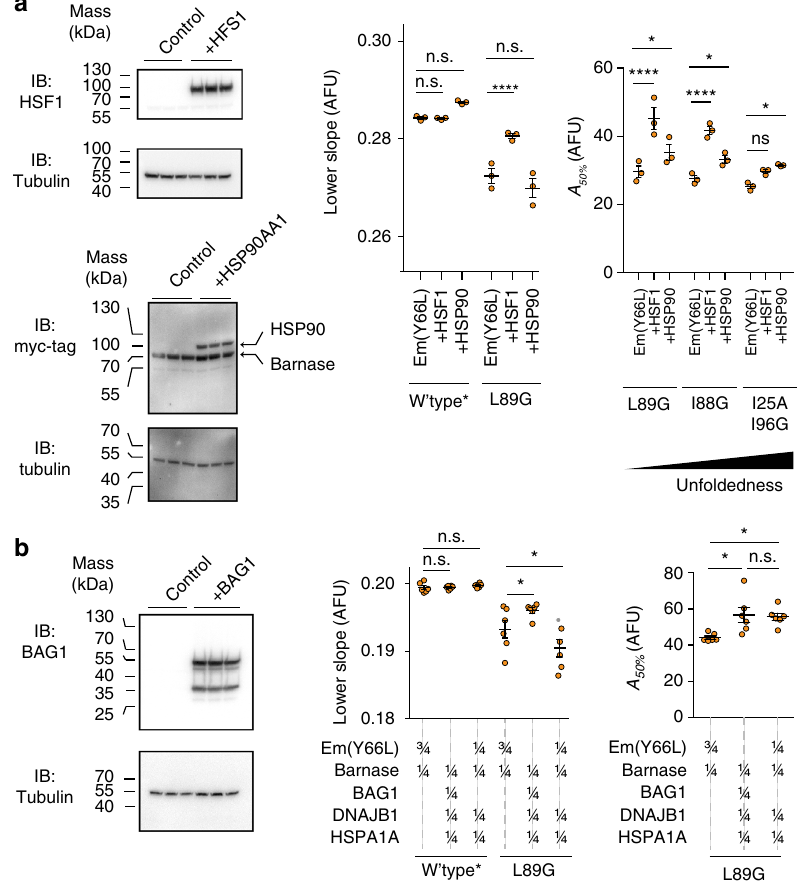
Fig. 6 Probing changes in proteostasis through selective activation of different chaperone systems. a Investigation of the effect of induction of the heat shock response by HSF1 overexpression or selective overexpression of HSP90. Shown on left are western blots of the HEK293T cells matched for total protein via a BCA assay. These cells were co-transfected with HSF1 (or myc-tagged HSP90 or control of (non- fl uorescent) Y66L Emerald fl uorescent protein) and the L89G barnase biosensor (which also contains a myc tag). The right graphs show the Lower-slope and A 50% analyses of these treatments and one or three of the biosensor variants as indicated vs. the wild-type* variant. Bars indicate means ± SEM. The right panels were analysed via a two-way ANOVA subjected to a Dunnett ’ s post-hoc test, results coded as **** p < 0.0001, *** p < 0.001, ** p < 0.01, * p < 0.05, ns = > 0.05. b Same paradigm as panel a. In this case, BAG1 was cotransfected with the barnase biosensor, HSP40 (DNAJB1) and HSP70 (HSPA1A). The right panels show the proportional dosage of each construct (by mass of DNA) in the transfection. Bars indicate means ± SEM. The right panel Lower-slope graph was analysed via a two-way ANOVA subjected to Dunnett ’ s post hoc test and the A 50% graph was analysed via a one-way ANOVA subjected to a Tukey ’ s post-hoc test. Results coded as **** p < 0.0001, *** p < 0.001, ** p < 0.01, * p < 0.05, ns = >